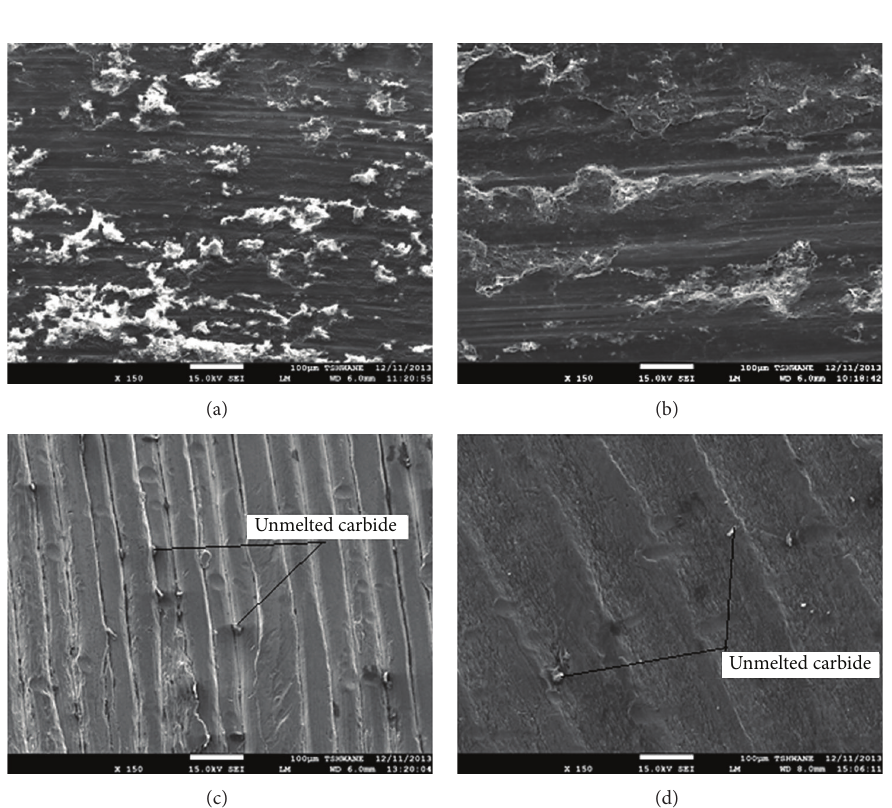
Figure 14: SEM micrograph of wear track of (a) sample D, (b) sample F, (c) sample G, and (d) sample